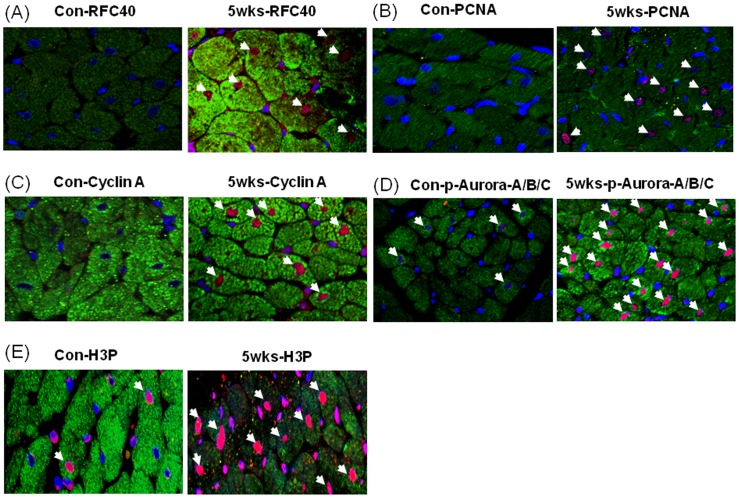
Immunohistochemical analyses revealed RFC40, PCNA, Cyclin A, phosphor-Aurora A/B/C kinase and pHis3 positive CMs nuclei in hypertrophied RV.Control (Con) and SUHxNx-5 wks (5 wks) RV sections (n = 3) were incubated with polyclonal anti-RFC40 (A) anti-PCNA (B), anti-Cyclin A (C), anti-phosho Aurora A/B/C kinase (p-Aurora-A/B/C; D) and anti-H3P (E) antibodies, respectively, and then with Alexa-568-labeled anti-rabbit and Alex-488-labeled anti-mouse secondary antibodies, respectively. Images were collected using an Olympus Plan x20/NA 0.25 Phi objective. In each experiment, all data were collected at identical imaging settings. Arrows indicates positive CMs.